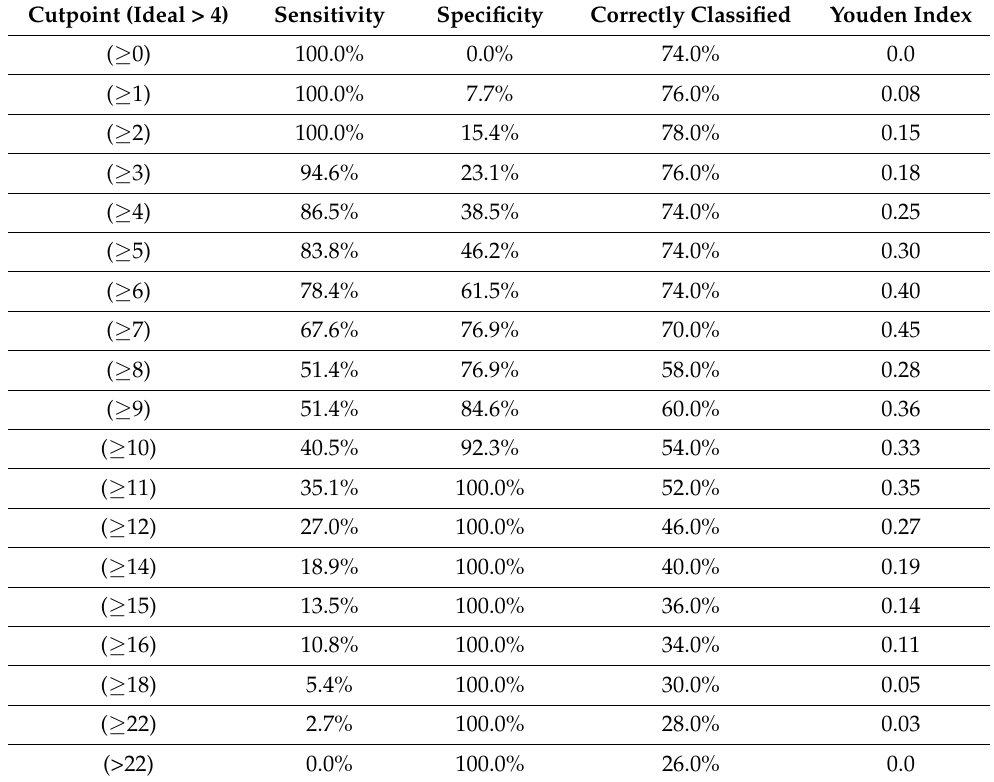
Table 2. Sensitivity, specificity, Youden Index at different cut off points of the EMR-screen PG-SGA.